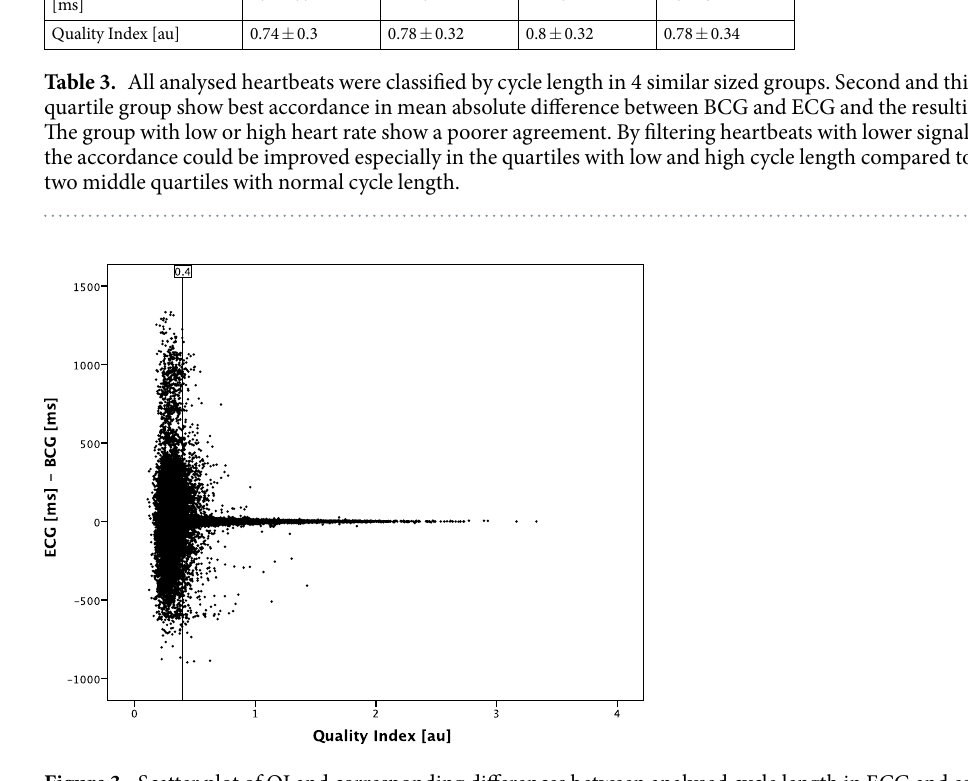
Figure 3. Scatter plot of QI and corresponding differences between analysed cycle length in ECG and estimated cycle length by BCG algorithm. To avoid clutter, randomly selected 10% of all analysed heartbeats are displayed. The scatter plot demonstrates: The higher the QI, the lower the difference between ECG and BCG measurement. An arbitrary cut-off line at the QI value of 0.4 is shown, indicating a correlation coefficient r s = 0.95 for the data points to the right of this cut-off